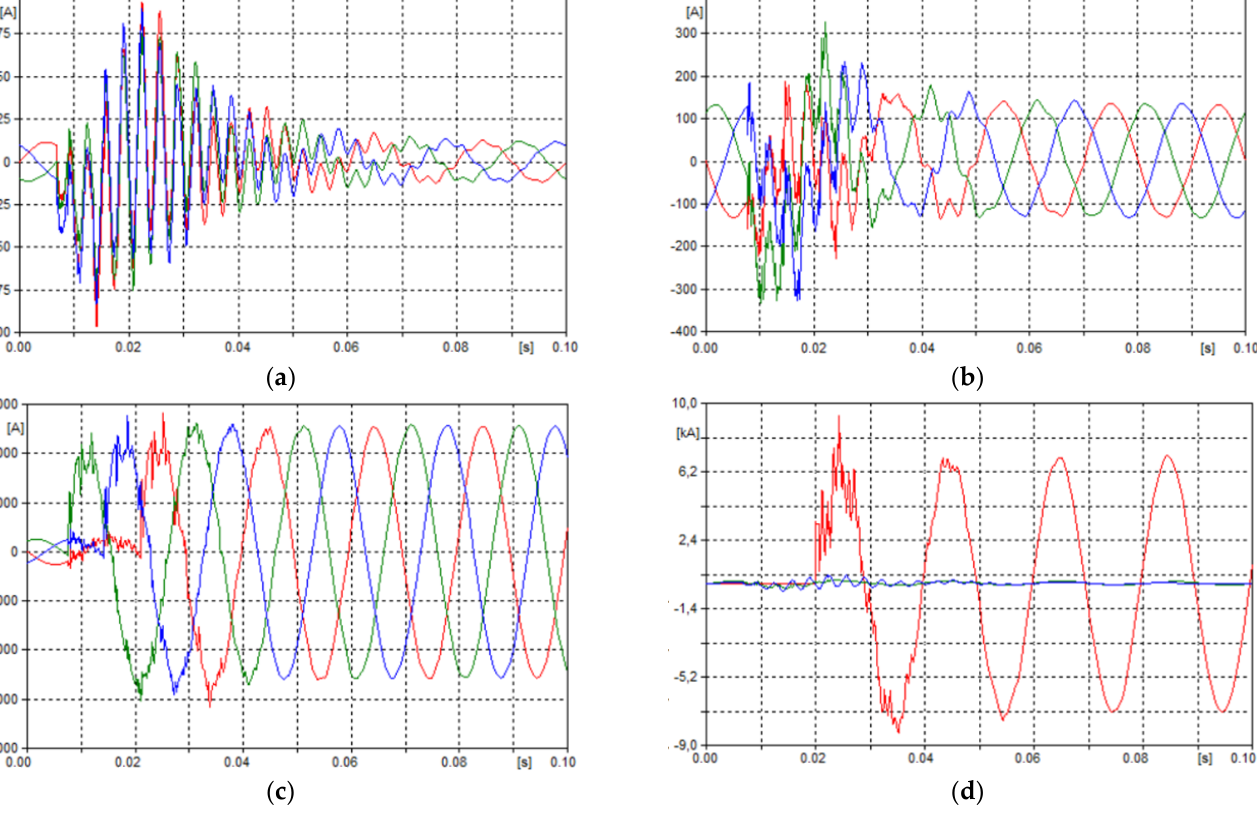
Figure 5. Current waveform in the damaged and “healthy” phases of a multi-system lines with different voltage levels: ( a ) for transmission line 110 kV (point WE3B); ( b ) for transmission line 220 kV (point WE2B); ( c ) for transmission line 400 kV (point WE1B); ( d ) in phase L1 for transmission line 110kV, 220 kV and 400 kV (point